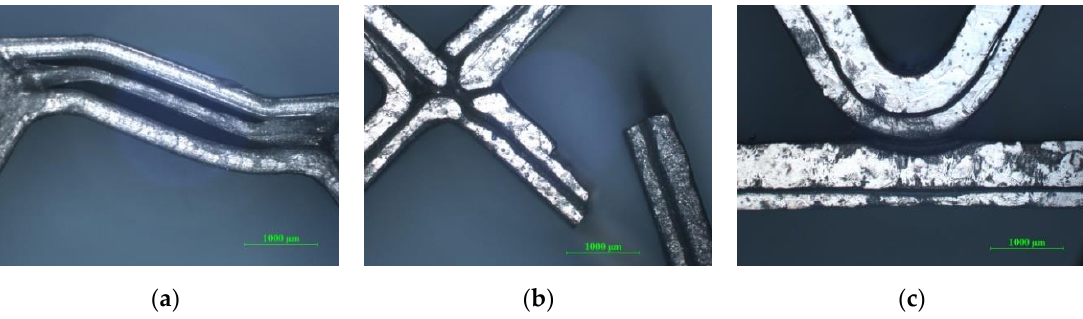
Figure 11. Optical micrographs of failed sandwich specimens subjected to three-point bending tests (magnification 25 × ): ( a ) Honeycomb core sandwich specimens; ( b ) Diamond-celled core sandwich specimens; ( c ) Corrugated core sandwich specimens.